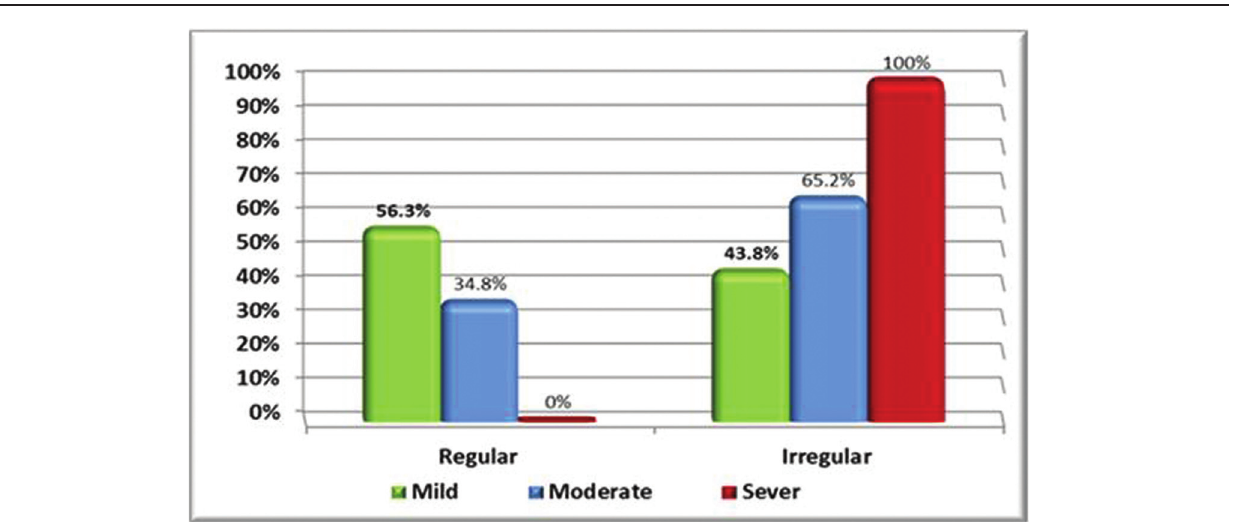
Illustrates the regularity of pleural line between different severity degrees